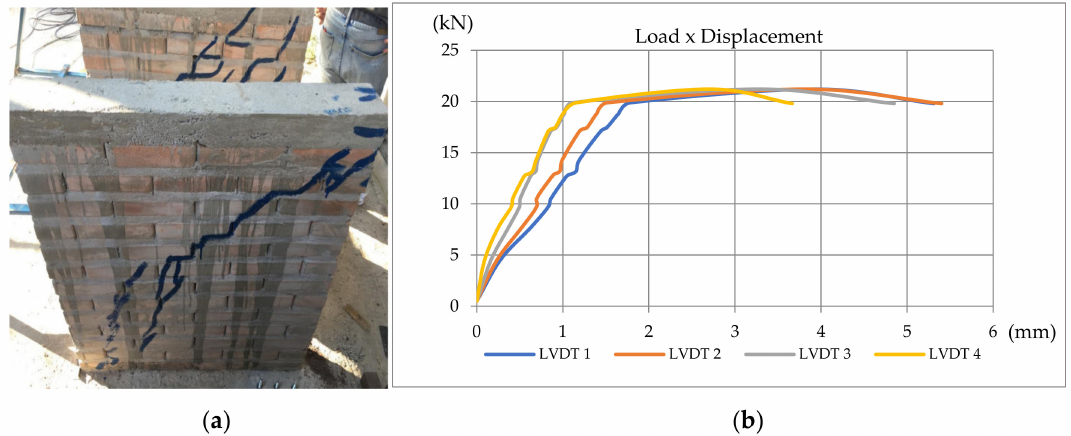
Figure 11. ( a ) Specimen 2; ( b ) Load–displacement curve for Specimen 2